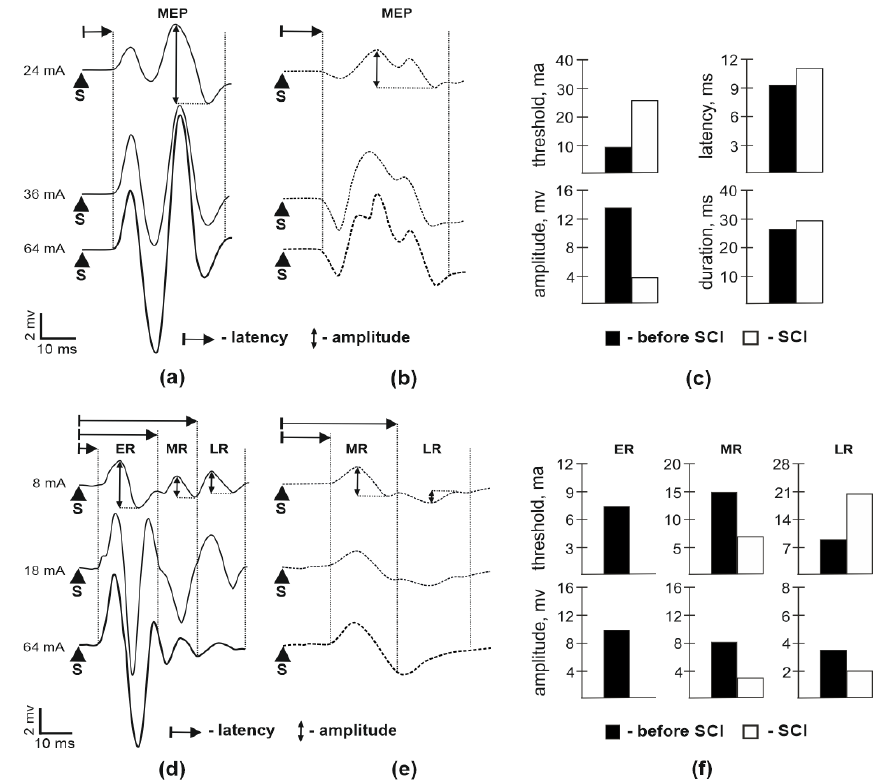
Figure 1. Motor evoked response potentials (MEP) in soleus muscle during spinal cord stimulation. ( a )—MEP in soleus muscle during stimulation at the cervical segment C5 before spinal cord injury (SCI); ( b )—MEP in soleus muscle during stimulation at C5 segment 14 days after SCI; ( c )—comparison between the different parameters of MEP in soleus muscle during stimulation at cervical segment C5; ( d )—responses in soleus muscle during stimulation at the lumbar segment L2 before SCI; ( e )—responses in soleus muscle during stimulation at the lumbar segment L2 14 days after SCI; ( f )—comparison between the different parameters of early response (ER), middle response (MR), and late response (LR) in soleus muscle during stimulation of at the lumbar segment L2. S—stimulus. Data obtained for each animal are presented as points, bars represent group-wise average